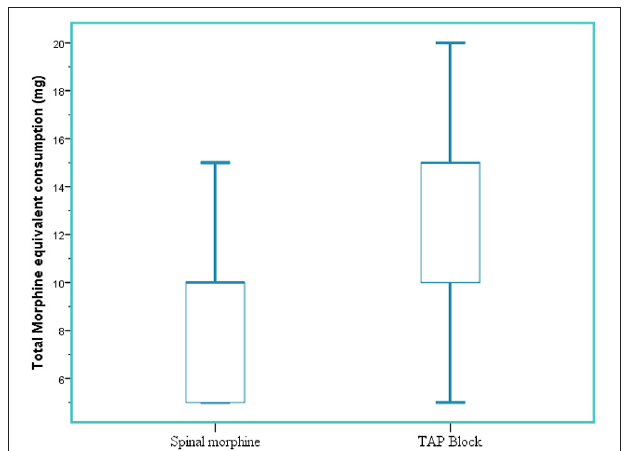
FIGURE 5 | Total 24-h morphine equivalent analgesic consumption. SM, spinal morphine; TAP block, transversus abdominis plane block; mg, milligram; IQR, interquartile range. The horizontal line indicates median, and hinges indicate first and third quartiles. Whiskers extend to the largest and smallest values not more than 1.5 ×